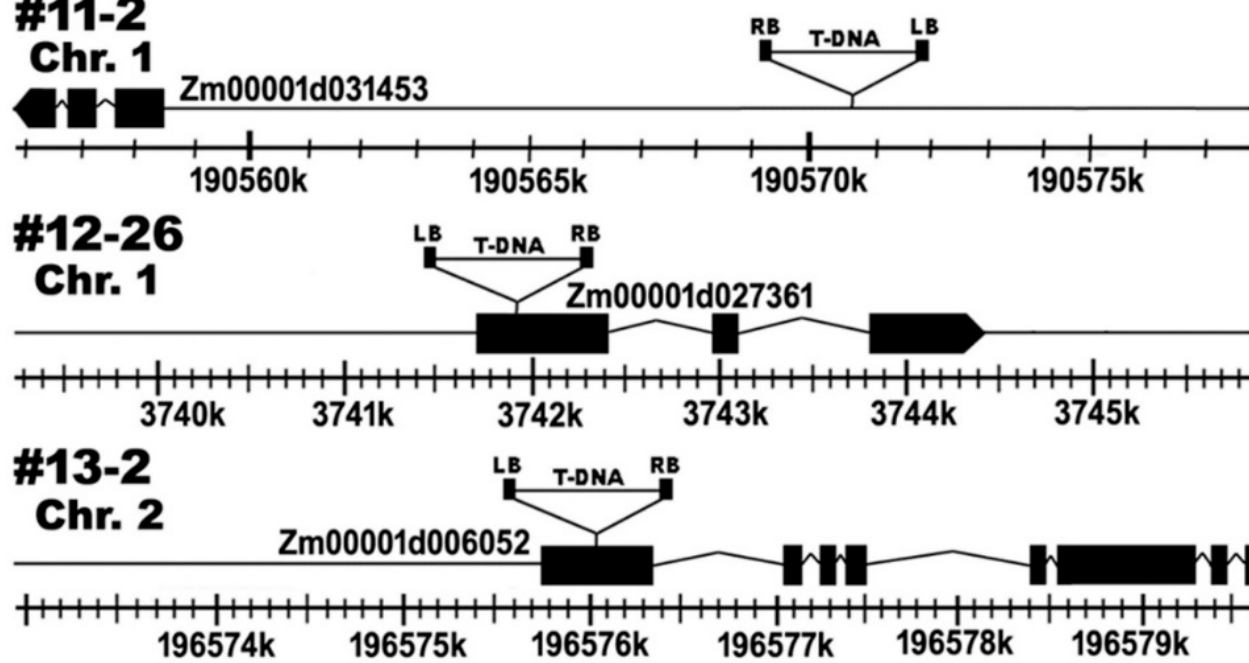
Figure 1. Positions of the T-DNA insertions in individual OsPYL/RCAR7 -OX transgenic maize lines. Black boxes indicate exons. Numbers indicate chromosome positions. LB and RB indicate left and right borders of the T-DNA, respectively. #1101, #12–16, and #13–2 are the selected transgenic lines. We crossed the progeny of the selected lines (#11–2 and #13–2) to plants from the maize inbred line B73 (Zm- OsPYL/RCAR7 -OX ♀ × B73 ♂ and B73 ♀ × Zm- OsPYL/RCAR7 -OX ♂ , named Type-A and Type-B, respectively) to produce the F 1 gener- ation (Table S2). In normal growth conditions, no significant differences in agricultural traits were found between the OsPYL/RCAR7 -OX plants and the wild-type plants (data not shown). These results suggest that the overexpression of OsPYL/RCAR7 shows no de- fect in maize growth under normal field conditions. We used PAT-test strips, genomic DNA PCR, RT-PCR, and a genotyping analysis of F 1 individuals to select individuals with a transgene ratio of 100% for drought-tolerance analysis (Figure S4 and Table 1). These lines were named according to their types: Type-A: 11A-5, 11A-8, 13A-5, 13A-9, and 13A- 12; Type-B: 11B-5, 11B-8, 13B-5, 13B-9, and 13B-12. Table 1. Summary of the genotypes of F 1 hybrid transgenic maize lines #11–2 and #13–2. F 1 —Type-A, B73 ( ♀ ) × T 1 ( ♂ )